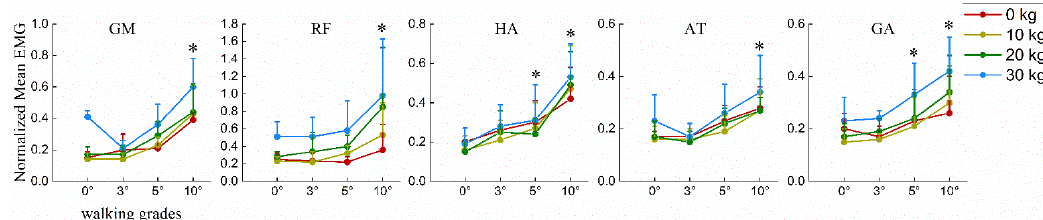
Figure 2. The mean EMG signals for muscles during different slope walking across all load masses in one gait from right heel strike to the next right heel strike, normalized to the mean activity during level walking without backpack loads. * Representing the mean EMG was significantly different from level walking across all the backpack loads, according to post hoc comparisons with a Bonferroni adjusted level of significance ( p < 0.0072). The red line represented the normalized mean EMG of each muscle at different grades without backpack loads. The yellow one represented the normalized mean EMG of each muscle at different grades with 10-kg backpack loads. The green one represented the normalized mean EMG of each muscle at different grades with 20-kg backpack loads. The blue one represented the normalized mean EMG of each muscle at different grades with 30-kg backpack loads.